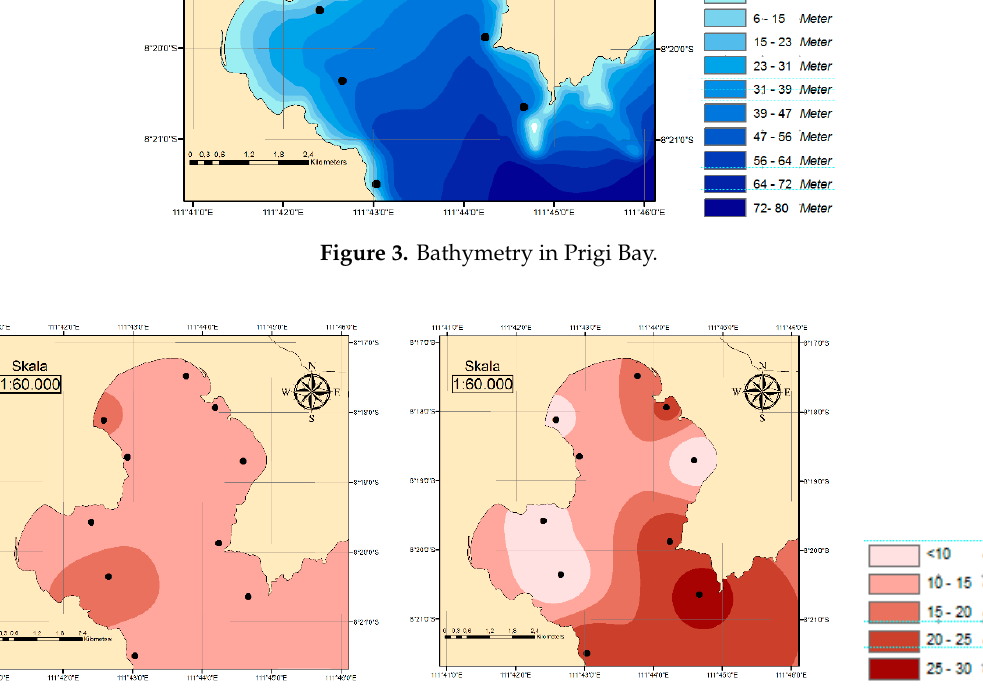
Figure 3. Bathymetry in Prigi Bay.